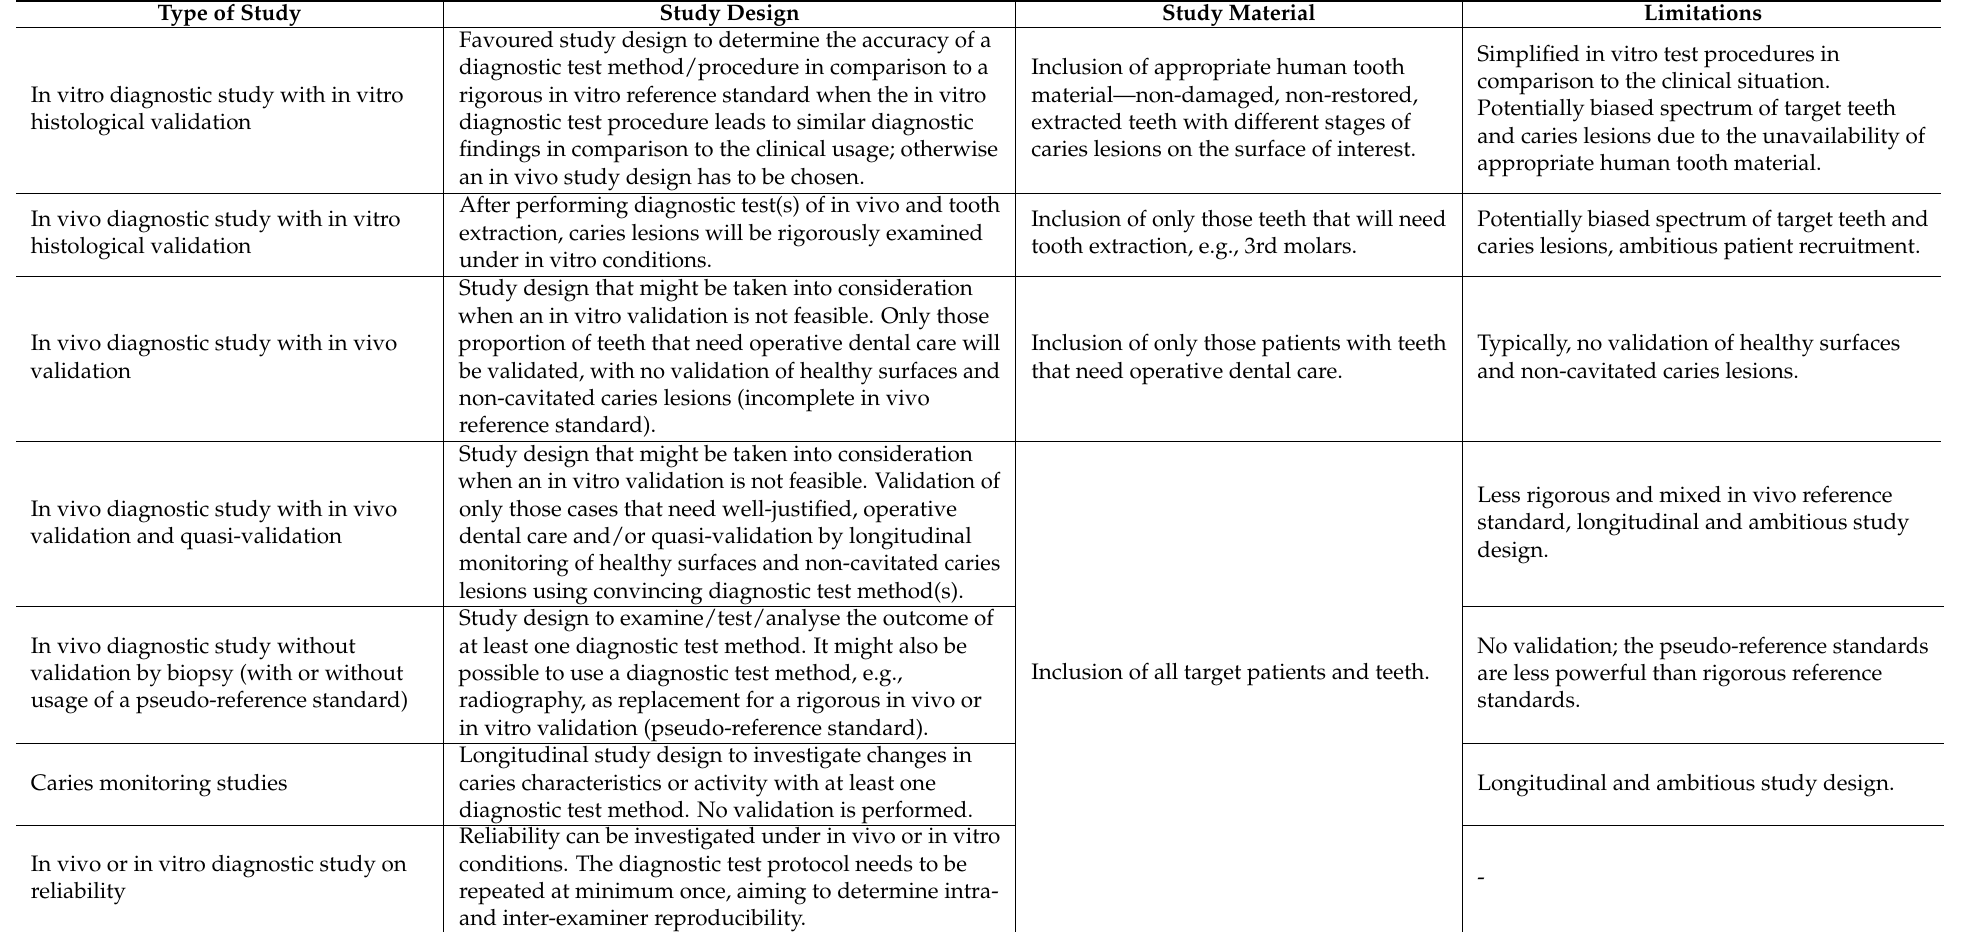
Table 1. Available types of studies for the investigation of diagnostic test methods for primary caries detection, diagnosis, assessment and/or